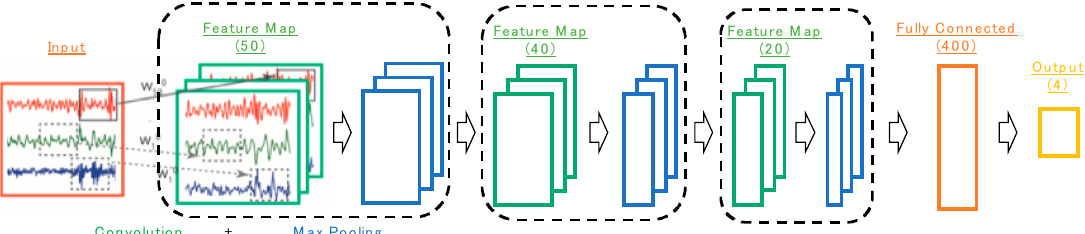
Figure 5. The structure of the deep convolutional neural network (DCNN) used in this paper.